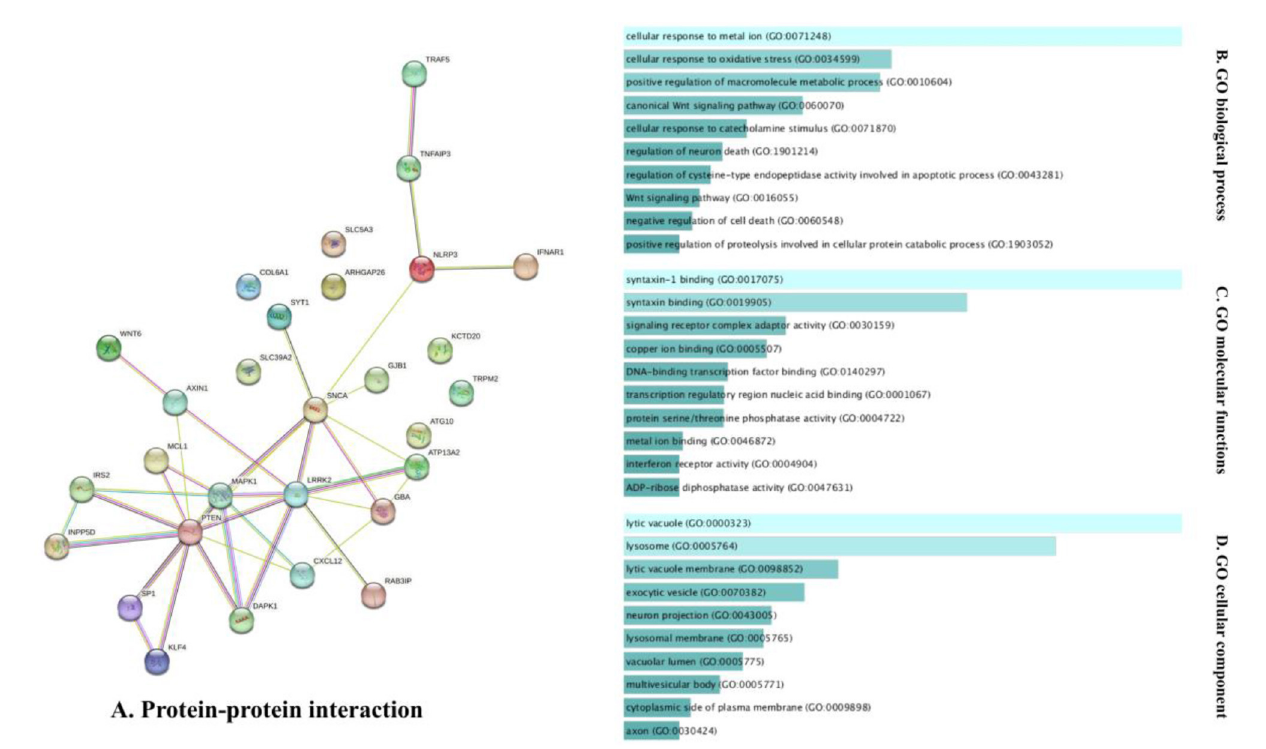
FIGURE3 The PPI interaction and GO enrichment analysis of target genes involved in ceRNA axes in PD. (A) The PPI interaction was established using the STRING-DB and includes 29 nodes and 37 edges. (B–D) The GO enrichment of target genes on the verified ceRNA axes. The P -values are used to rank the importance of each group, with the length of each bar indicating the significance level. The order of the bars is based on the p -value. Note that the higher the association with a certain category, the less intense the color of the bars.